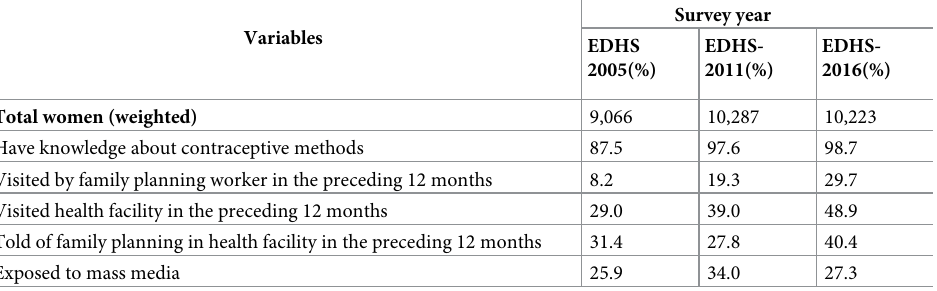
Table 2. Health facility related characteristics among currently married women in Ethiopia from